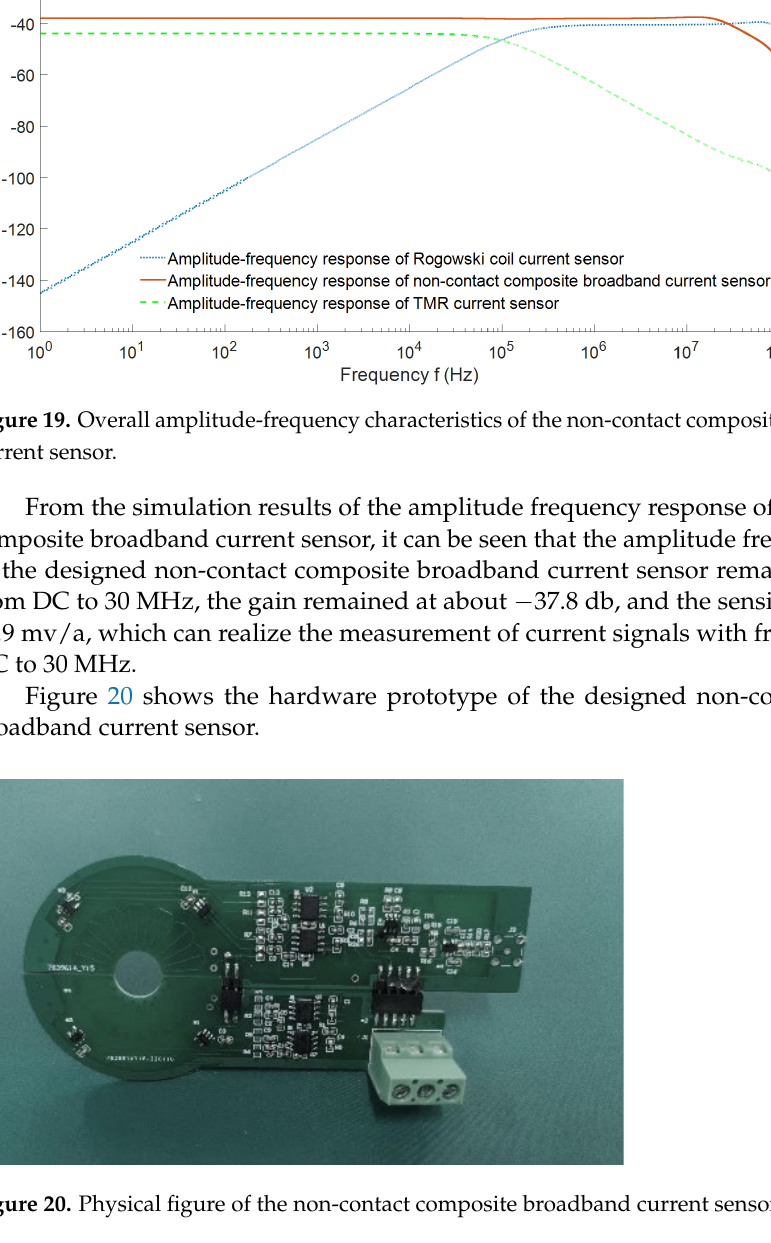
Figure 18. Overall simulation diagram of the contactless composite wide-bandwidth current sen- sor.